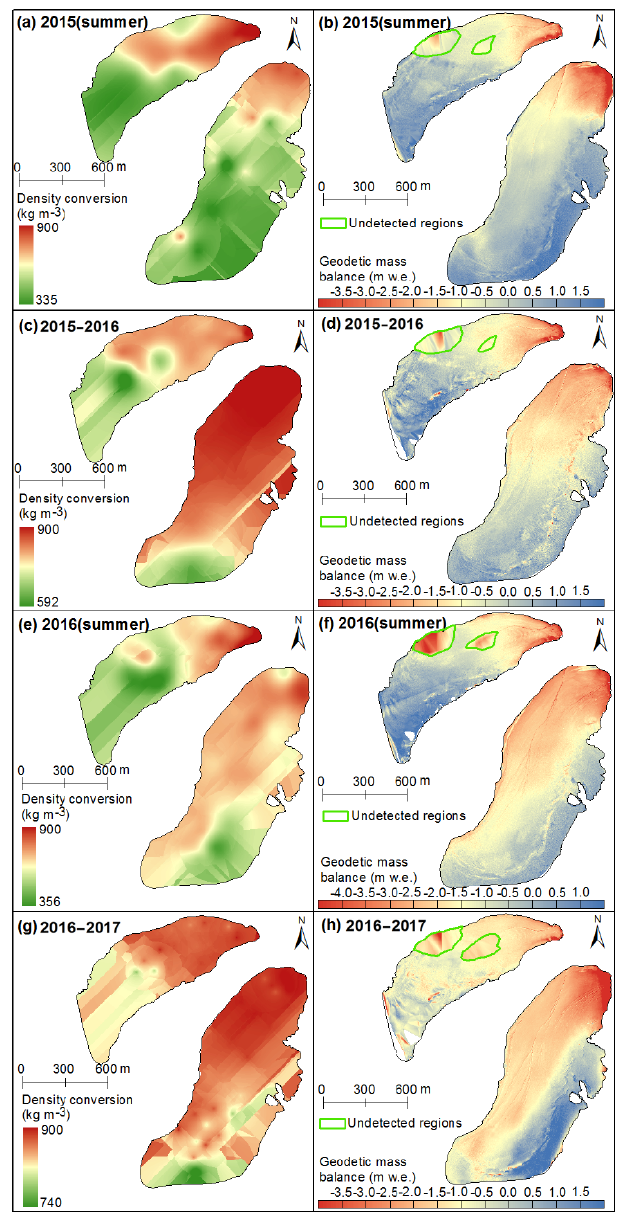
Figure 5. Distributed density conversions (a, c, e, g) and corre- sponding glacier-wide geodetic mass balance (b, d, f, h) . Two green polygons indicate areas that have not been detected by the